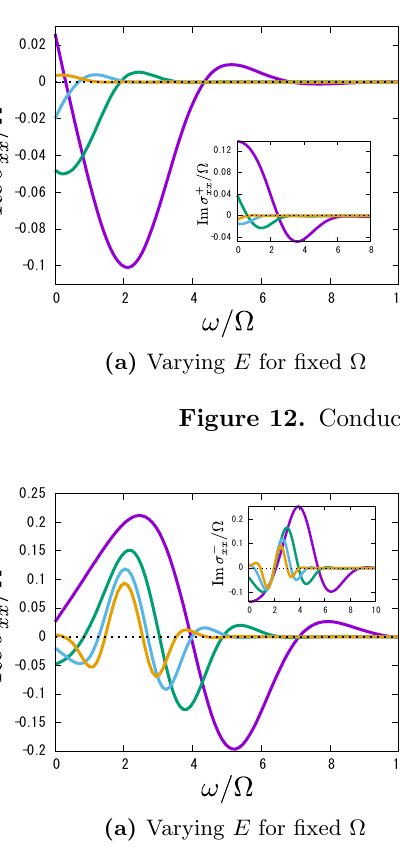
Figure 13. Conductivity (cid:27) (cid:0)